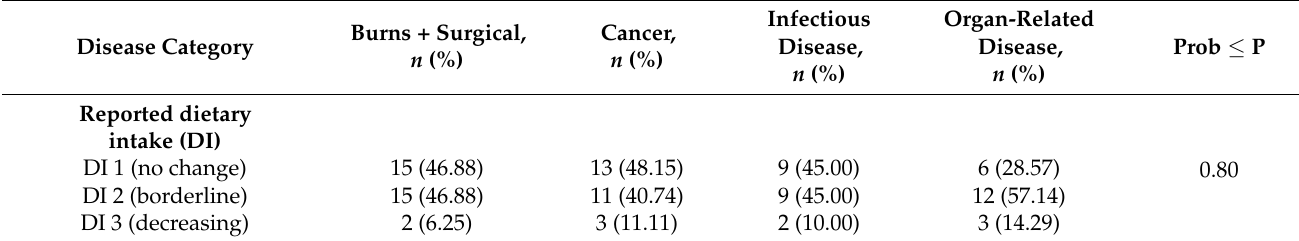
Table 5. Disease category by reported dietary intake.